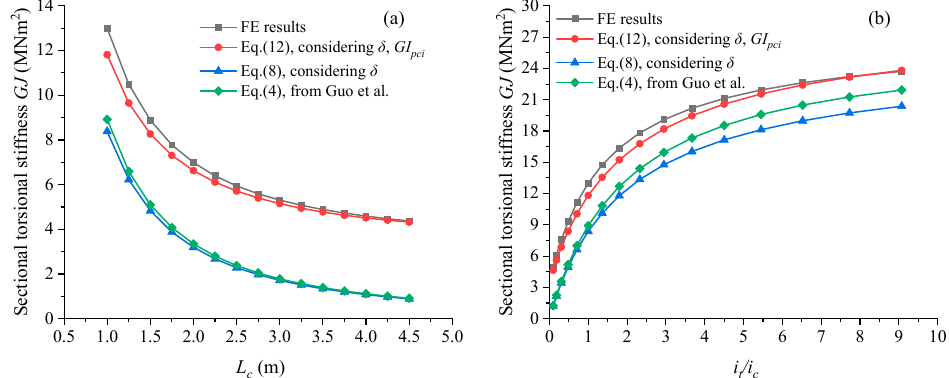
Figure 8. Sectional torsional stiffness and as a function of ( a ) segment length or ( b ) i t / i c for the equivalent straight trusses obtained from FE results and derived equations [33].